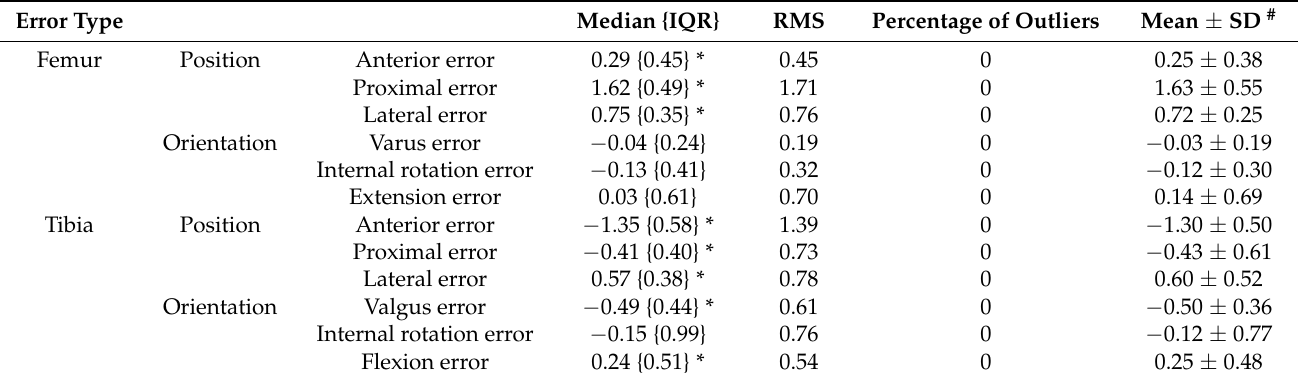
Table 1. Pooled errors of the three surgeons ( n = 30